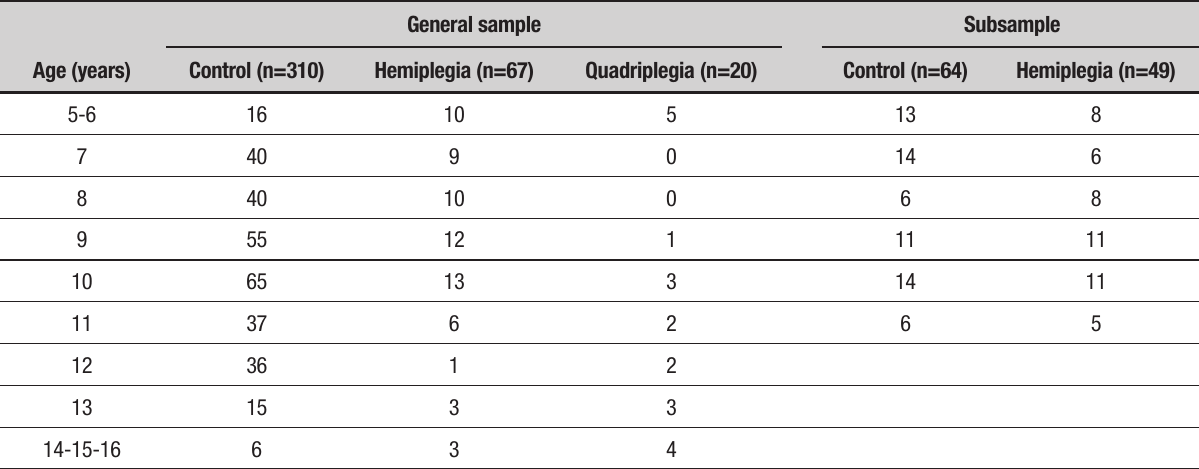
Table 1. Sample sizes by age and